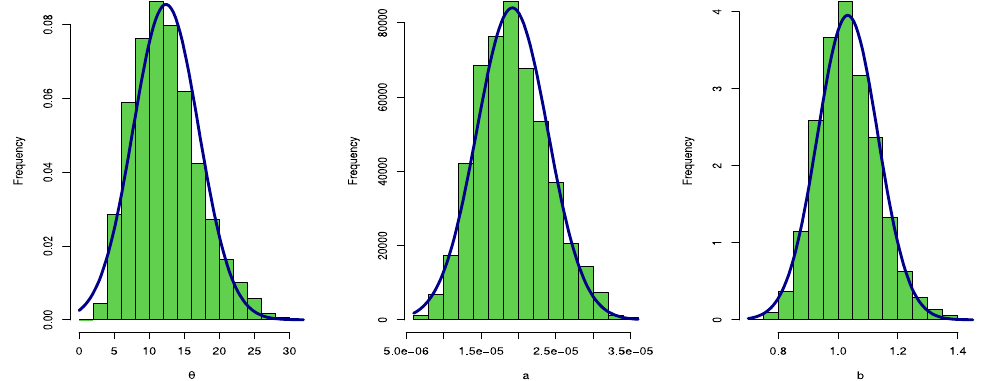
Figure 4. Iterations of MCMC results for progressive-stress model. Where g e-06 is g × 10 − 6 and g is value of parameter g without virgule.